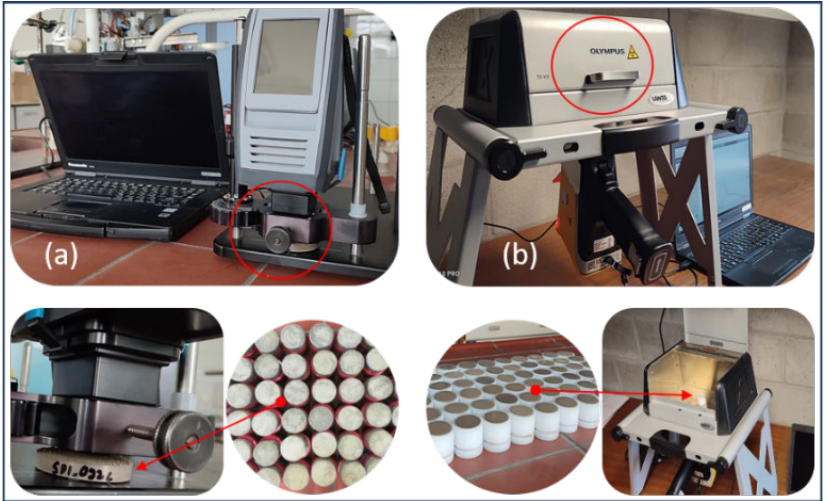
Figure 2. Experiment process for soil measurement. ( a ) mid infrared (MIR) scanning of soil samples, ( b ) X-ray fluorescence (XRF) scanning of soil samples.